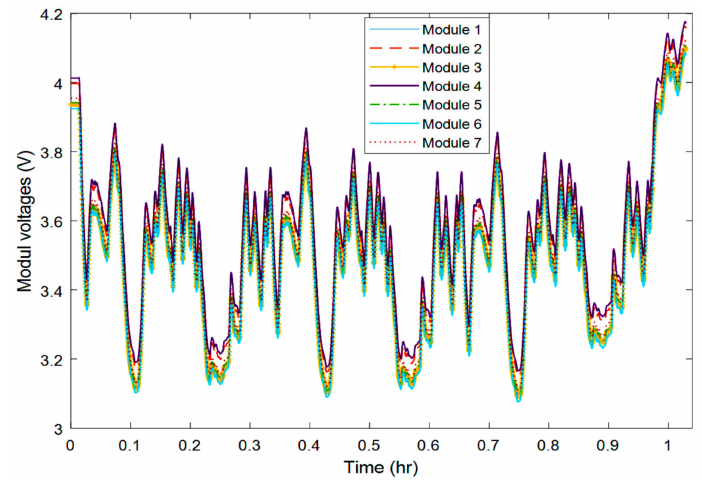
Figure 8. The current through the LiBP in the charge and discharge scenarios.